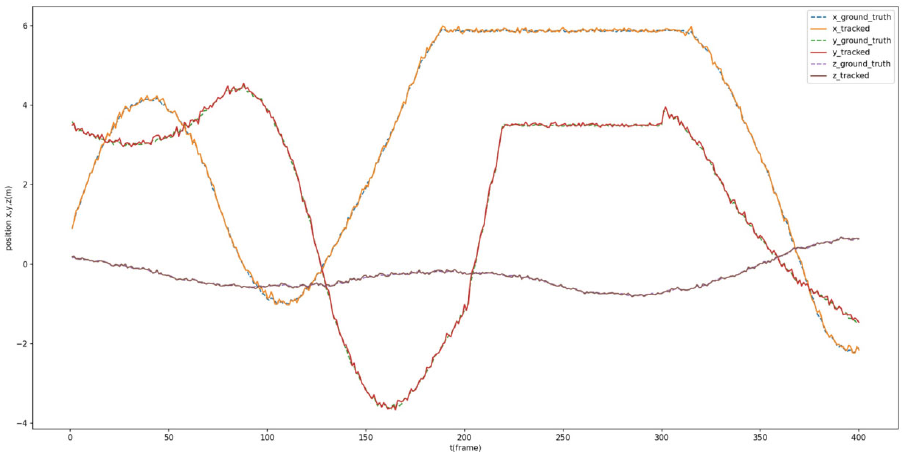
Figure 12. Comparison between the estimated position and ground truth of Procapra przewalskii.